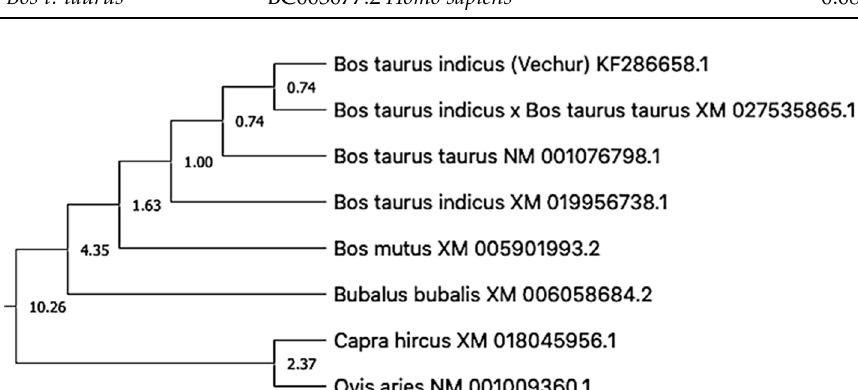
Figure 5. Percent identity (upper half) and divergence (lower half) of the predicted ATP1A1 protein sequence of Vechur cattle with similar sequences in the database.